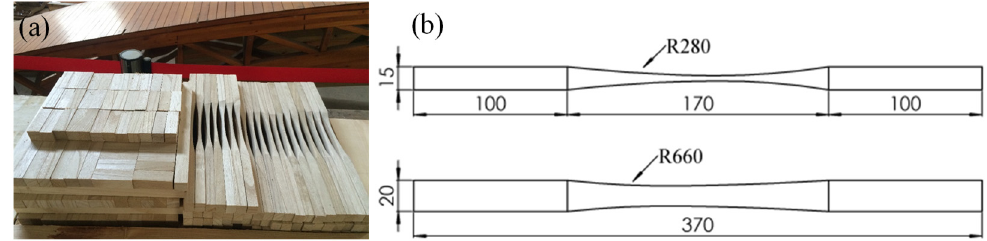
Figure 1. Specimen details: ( a ) overview and ( b ) geometry of the tensile specimens.